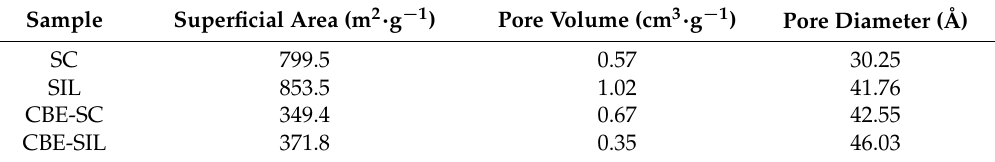
Table 2. Physicochemical properties of silica xerogel supports (SC or SIL) and lipase from Burkholderia cepacia immobilized by covalent binding onto control silica (CBE-SC) or silica produced with protic ionic liquid